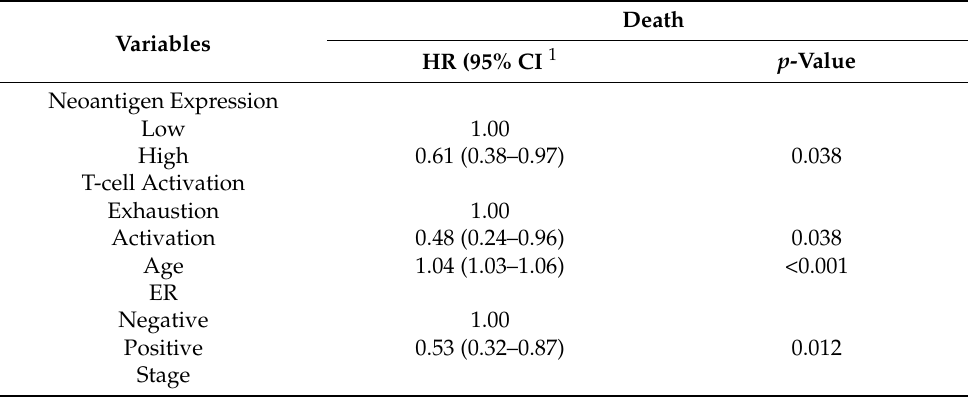
Table 2. Relationship between overall survival and neoantigen